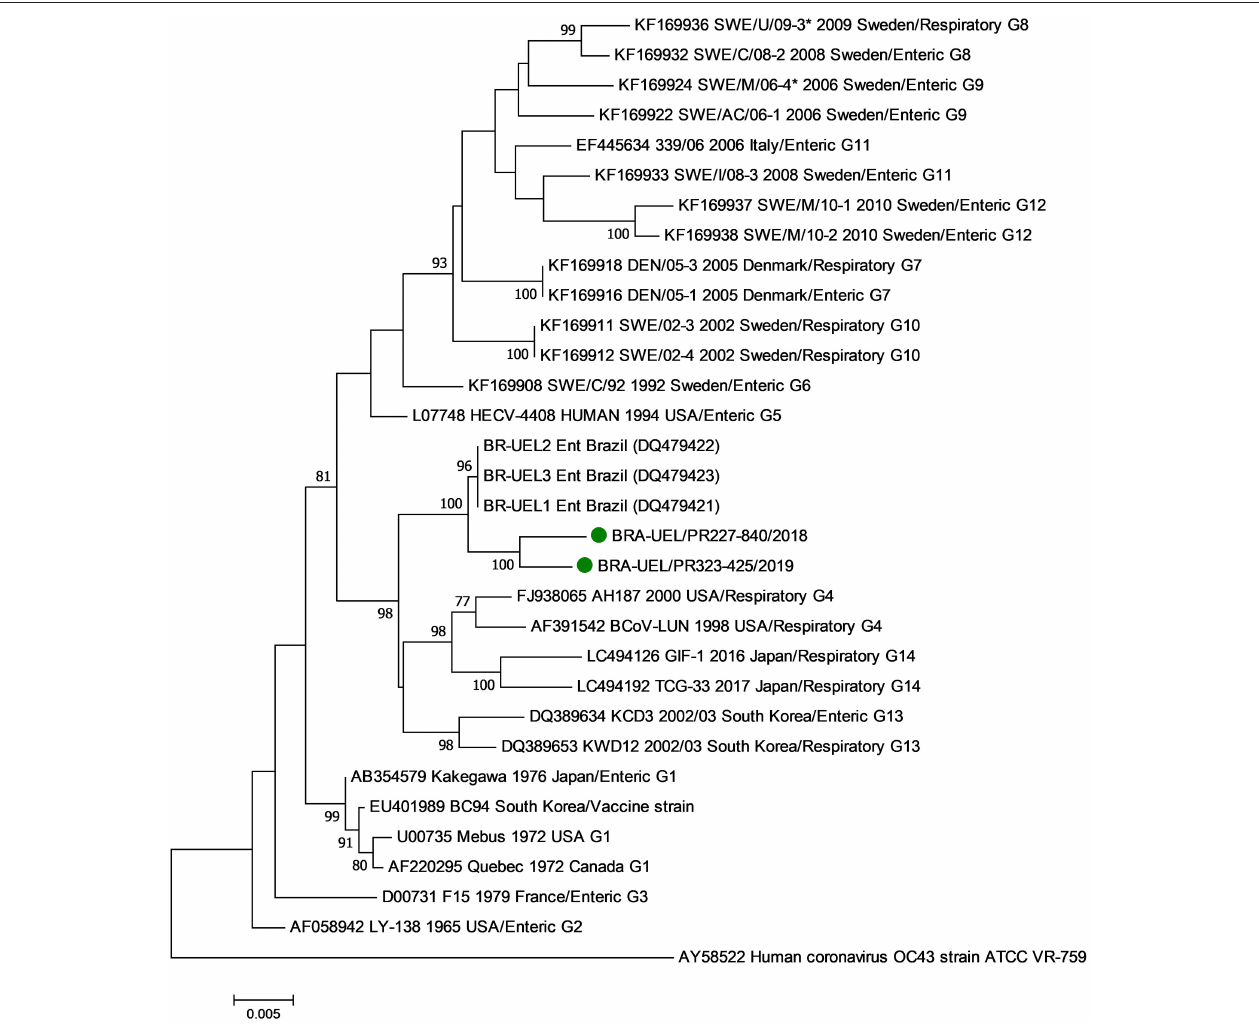
FIGURE 3 | Phylogenetic analysis by the maximum likelihood method of the partial (2581 nt) S gene of bovine coronavirus strains. The evolutionary history was inferred by using the maximum likelihood method based on the general time reversible model. The percentage of trees in which the associated taxa clustered together is shown next to the branches. The tree is drawn to scale, with branch lengths measured in the number of substitutions per site. The analysis involved 29 nucleotide sequences of bovine coronavirus. A human coronavirus OC43 sequence was used as an outgroup. Evolutionary analyses were conducted in MEGA7. The BCoV strains identified in this study are marked with green filled